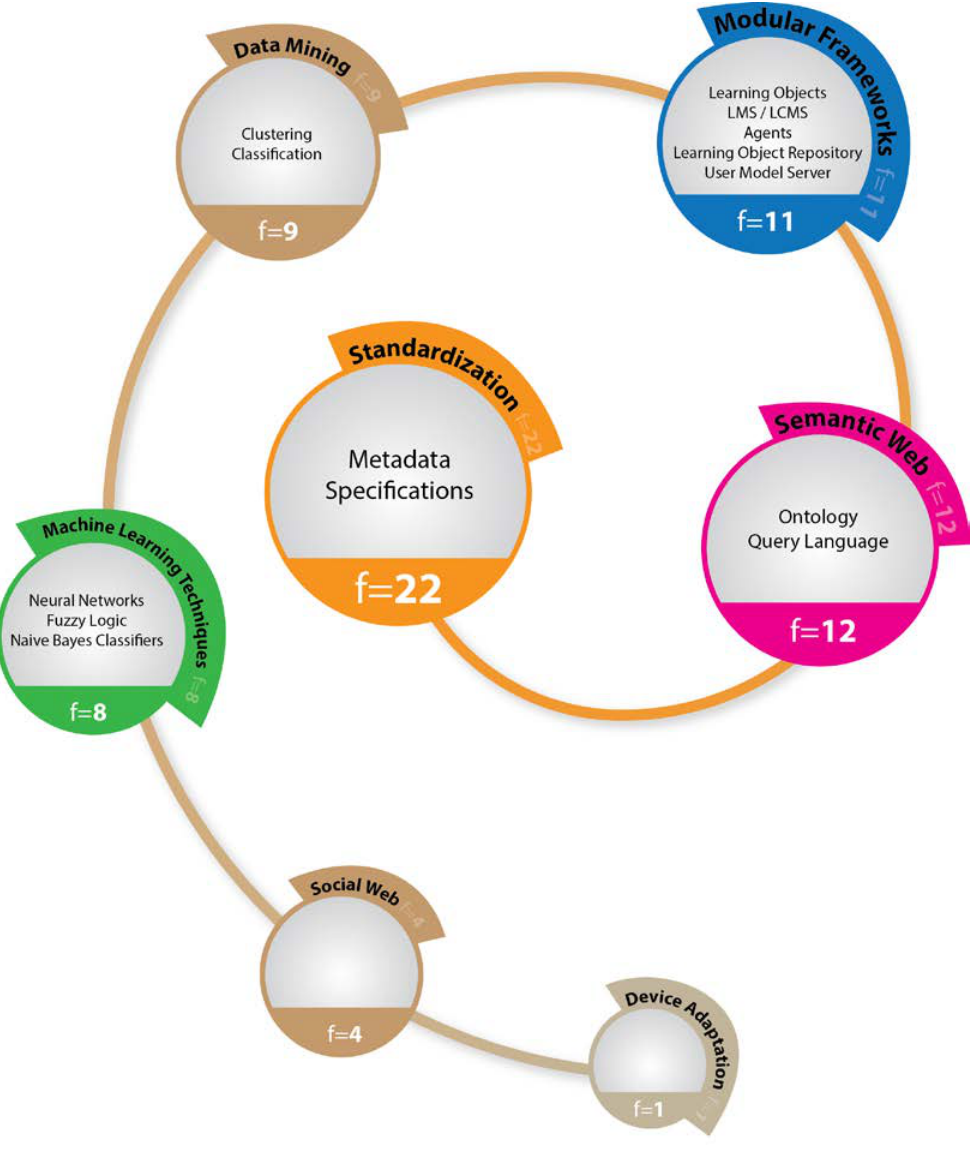
Figure 2 . Classification of the studies by new technological trends and